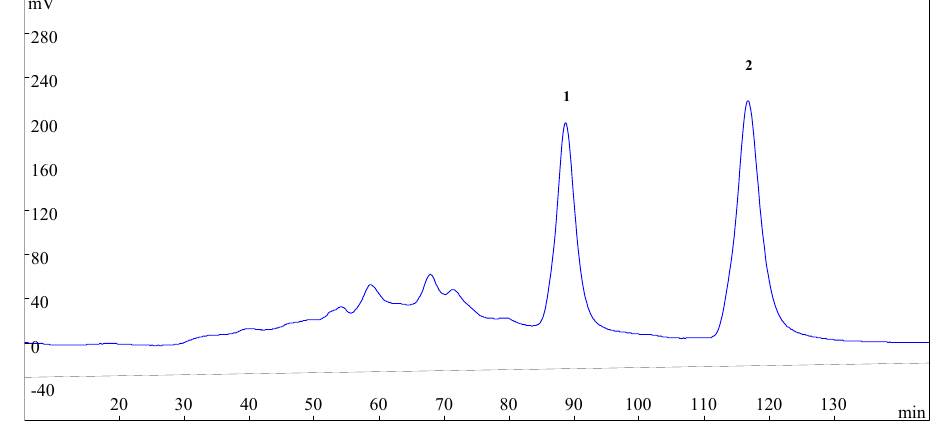
Figure 3. HSCCC chromatogram of the enriched sample from SLHC. Two-phase solvent system: n -hexane–ethyl acetate–methanol–water (3.5:5:3.5:5, v / v ); mobile phase: the lower phase; stationary phase: the upper phase; flow rate: 2.0 mL·min − 1 ; revolution speed: 800 rpm; detection wavelength: 254 nm; sample size: 200 mg enriched sample was dissolved in the solvent mixture of n -hexane–ethyl acetate–methanol–water (5 mL for each phase).